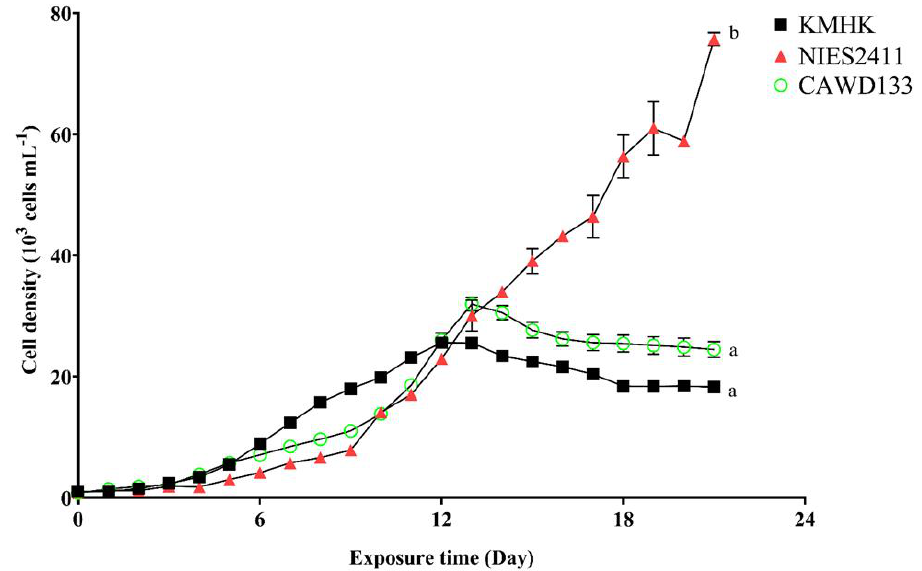
Figure 2. Growth curves of the three K. mikimotoi strains (KMHK, NIES2411 and CAWD133) growing in L1 medium and 30 ppt salinity for 21 days. Data points represent mean ± standard error of the mean (SEM) cell densities of three replicate cultures. Different small letters indicate significant difference between the cell densities of the three K. mikimotoi strains at day 21. Table 1. Summary of specific growth rates and maximum cell densities of K. mikimotoi strains of different geographical